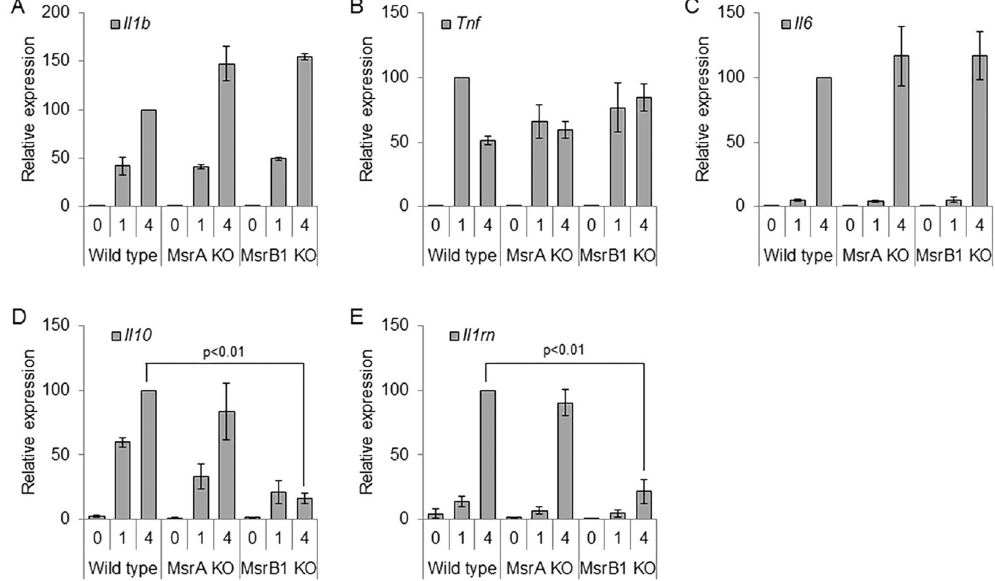
Figure 3. Analysis of cytokine mRNA expression. ( A – E ) Relative mRNA amounts for Il1b ( A ), Tnf ( B ), Il6 ( C ), Il10 ( D ), and Il1rn ( E ) in WT, MsrA KO, and MsrB1 KO BMDMs were measured after the indicated durations of LPS stimulation. Data are presented as percent values relative to the mRNA amounts at four hours after LPS treatment in WT BMDMs. Error bars represent standard deviation. The experiments were independently repeated two